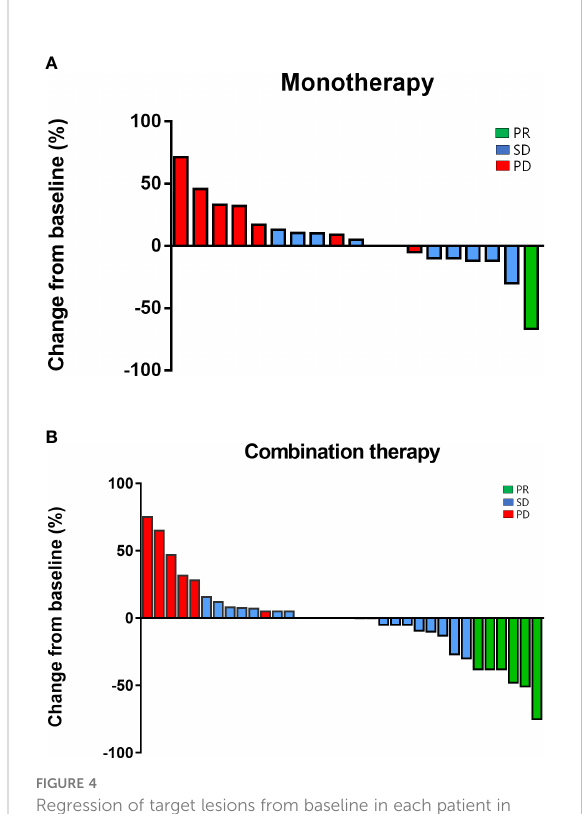
FIGURE 4 Regression of target lesions from baseline in each patient in (A) the monotherapy group and; (B) the combination